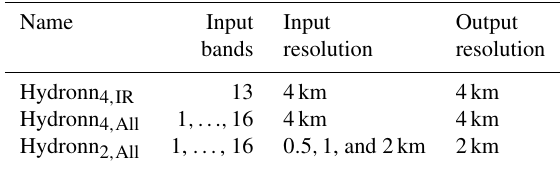
Table 1. Hydronn retrieval